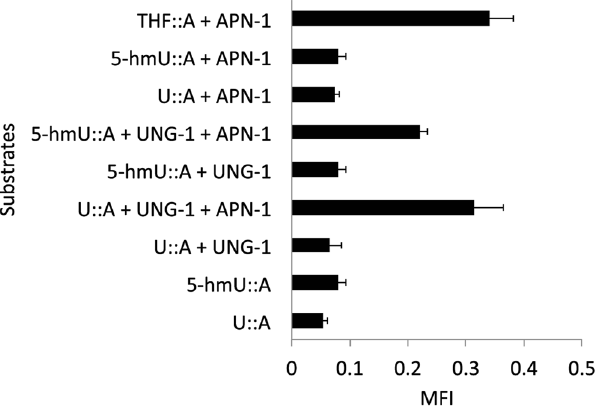
Figure 6. Recombinant GST-UNG-1 acts on 5-hmU lesion to produce APN-1 cleavable AP site. GST-UNG-1 and GST-APN-1 were purified from E. coli and S. cerevisiae expression system, respectively 14,20 . The enzymes were incubated with the indicated stem-loop deoxyoligonucleotide substrates bearing either uracil, 5-hmU or the AP site tetrahydrofuran (THF) opposite adenine (U:A, 5-hmU:A and THF:A) at the six position from the 5 ′ -end bearing 6-Carboxyfluorescein 35 . UNG-1 was incubated with the substrates for 30 mins at 26°C followed by the addition of APN-1 and then a further incubation for 30 mins at 37°C. The enzymatic incision of the substrate released a fluorescently labeled 5-mer product that can be detected by a fluorometer (Fluoroskan